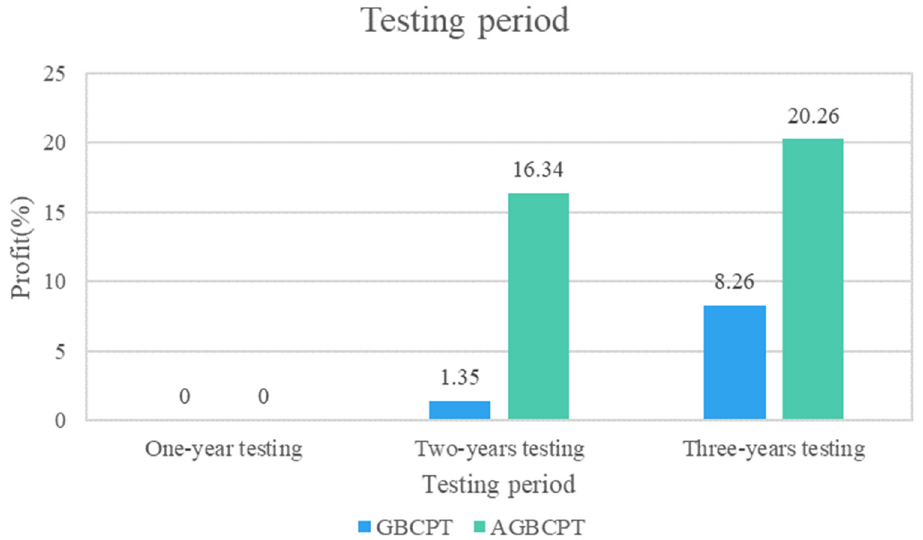
Figure 17. AGBCPT and GBCPT profits in different testing periods.